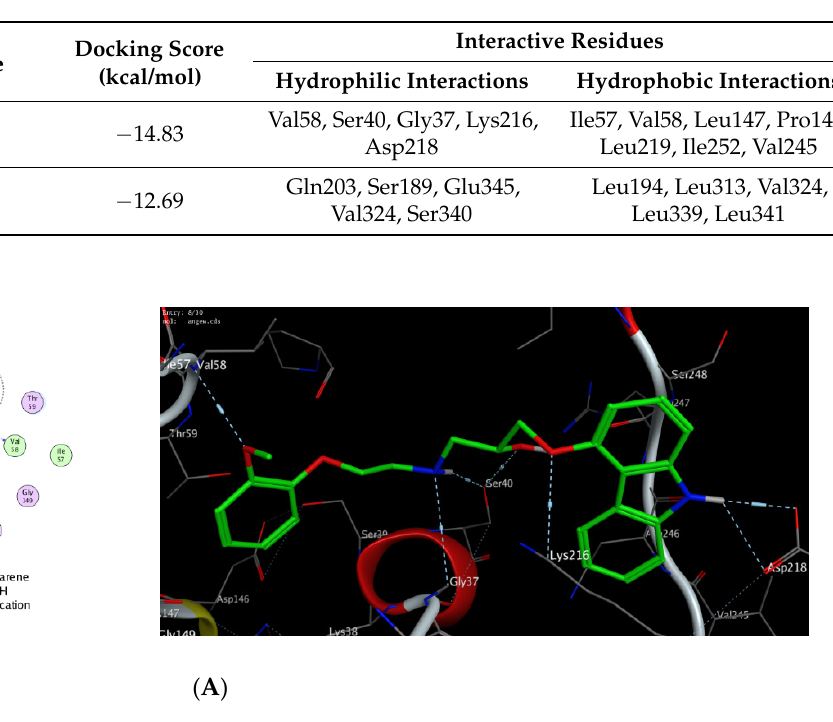
Table 5. Binding scores and interactive residues of carvedilol in the binding pocket of dynamin-1-like protein (DNM1L) and mitochondrial dynamics protein (MID51).